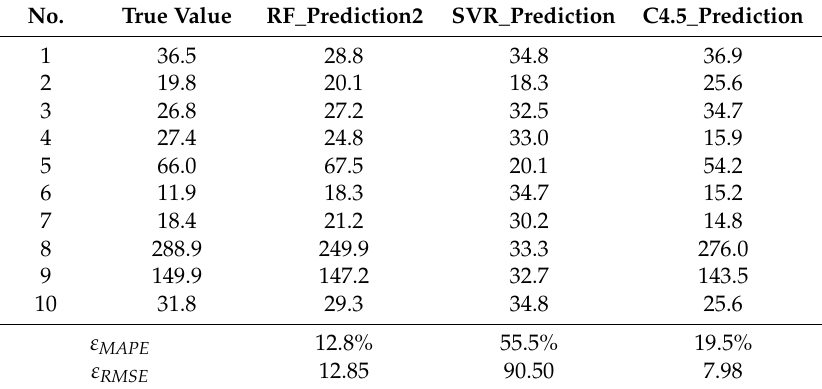
Table 3. 10 Prediction data for charging station group every day.